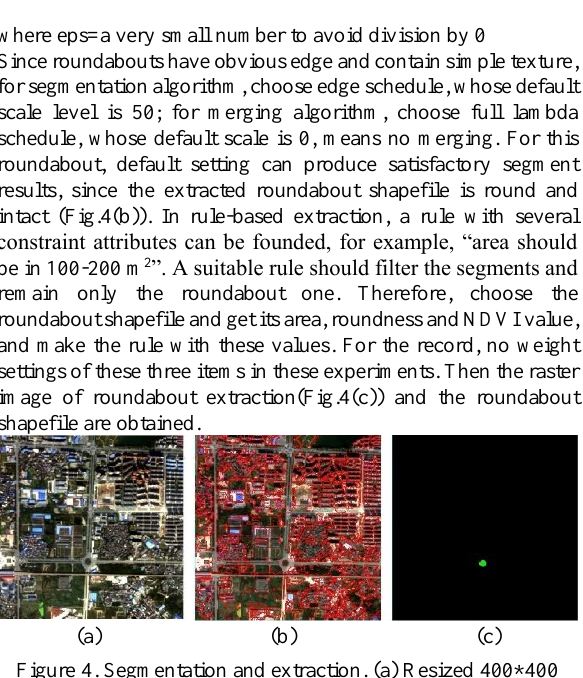
Figure 4. Segmentation and extraction. (a) Resized 400*400 pixel image. (b) Segmentation with numerous